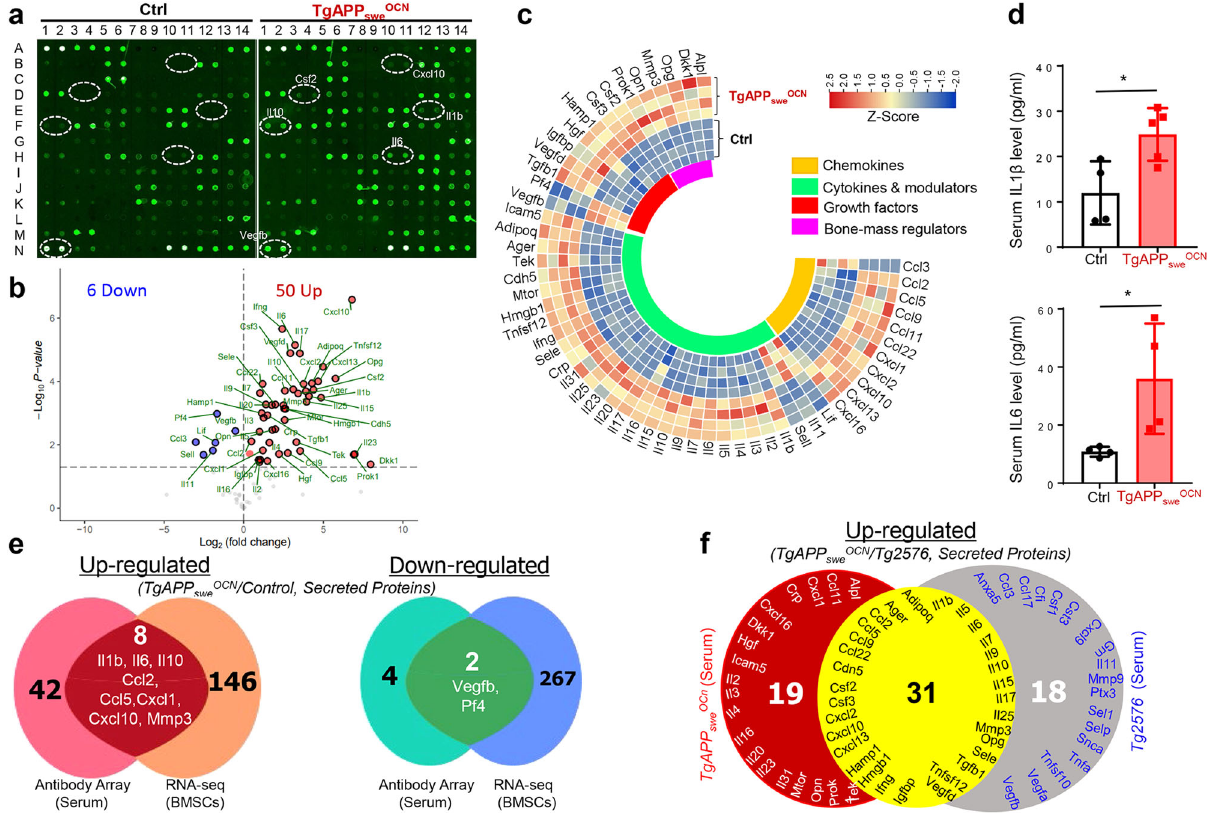
Fig. 8 Increased cytokines and chemokines in TgAPP swe OCN serum samples. a Representative images of serum L-Series label-multiplex antibody arrays of ~7-MO control and TgAPP swe OCN mice. b Volcano plots analysis of a . c Heat map of data in a . n = 4, signi fi cant difference was set at p < 0.05. d Elisa assays of serum IL1 β and IL6 levels in ~7-MO control and TgAPP swe OCN mice. The data were presented as mean ± SD ( n = 4 mice). * p < 0.05 by Student ’ s t test. e Comparison between this antibody array with secreted factors by RNA-seq of puri fi ed Tdtomato + BMSCs. f Comparison of the changes (upregulated secreted proteins in Tg2576 over control mice) to those detected in TgAPP swe OCN